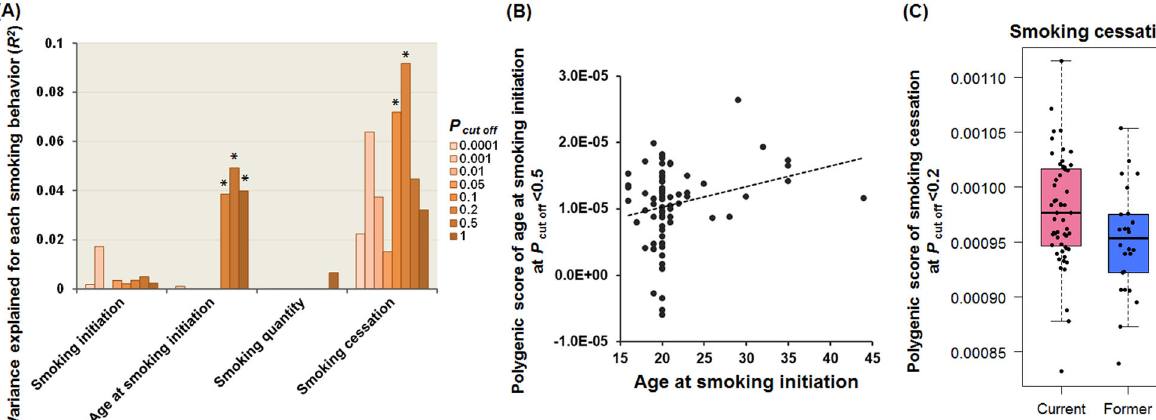
Fig. 1 Effects of polygenic risk scores (PRSs) for European-based smoking-related intermediate phenotypes on smoking behaviors in a Japanese population. Effects of PRSs for four European-based smoking-related intermediate phenotypes based on each threshold ( P T cutoff ) on each smoking-related intermediate phenotype in Japanese target subjects ( a ). The y-axis shows the adjusted R 2 or Nagelkerke ’ s pseudo- R 2 , indicating the explanatory power of the model. * p < 0.05. Positive correlation between PRSs related to European-based age at smoking initiation and age at smoking initiation in the target ever-smokers ( b ). Differences in PRSs based on European-based smoking cessation between Japanese current and former smokers ( c ). Box plots are used to visually show the distribution of PRSs. The median is shown by the center line that divides the box into two parts. Lower and upper bounds of box represent fi rst and third quartiles, respectively. The lower and upper whiskers represent scores outside the middle